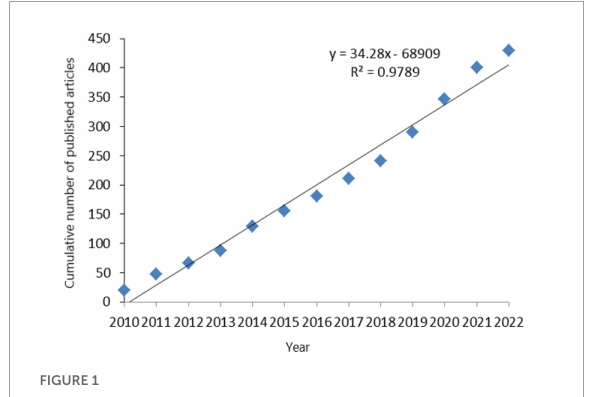
FIGURE1 Regression verification of the annual document volume of the WOS